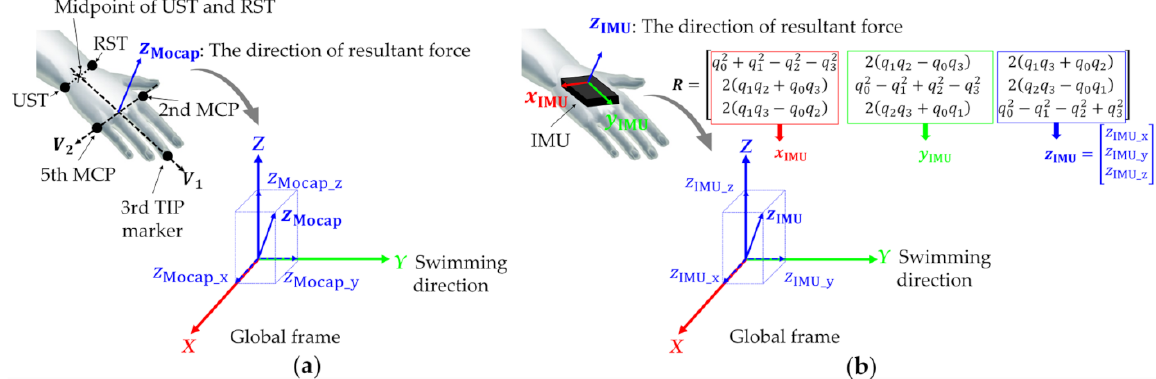
Figure 6. ( a ) Schematic diagram showing calculation of hand’s orientation using underwater motion-capture system. z Mocap (hand’s orientation) was calculated from the coordinates of five reflective markers on the hand (black dots). z Mocap_y represents the component of propulsive direction. ( b ) Schematic diagram showing estimation of hand’s orientation using IMU. Third column components of R represent 𝒛 𝐈𝐌𝐔 direction in global frame. 𝑧 IMU_y represents component of propulsive direction.